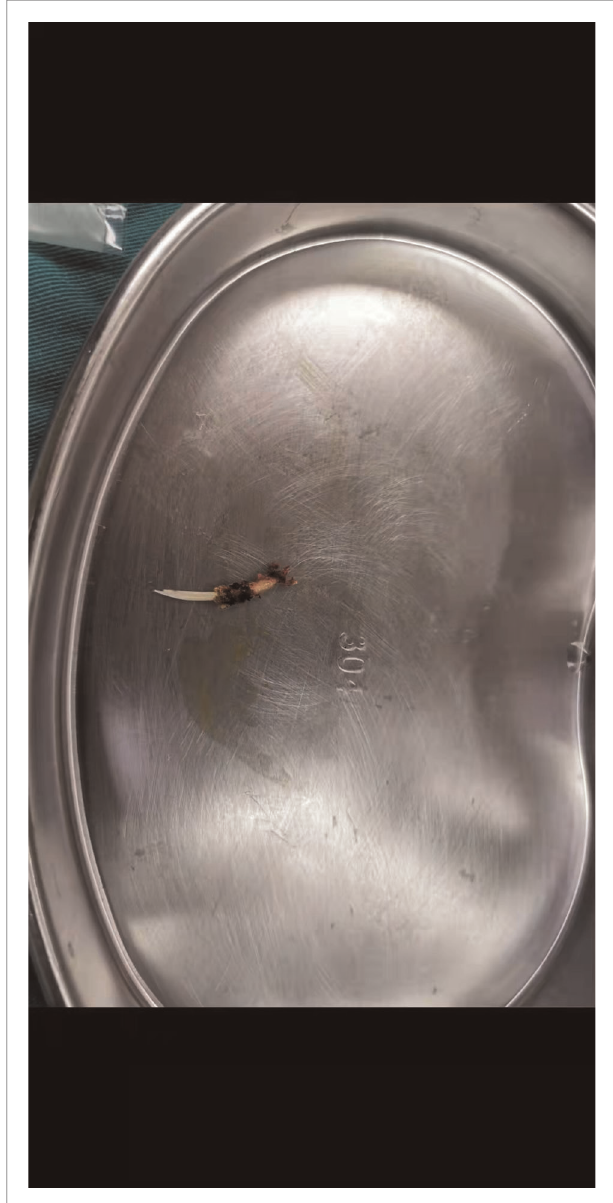
FIGURE 2 | Fish bone of length 2 cm and diameter 0.2 cm extracted from the